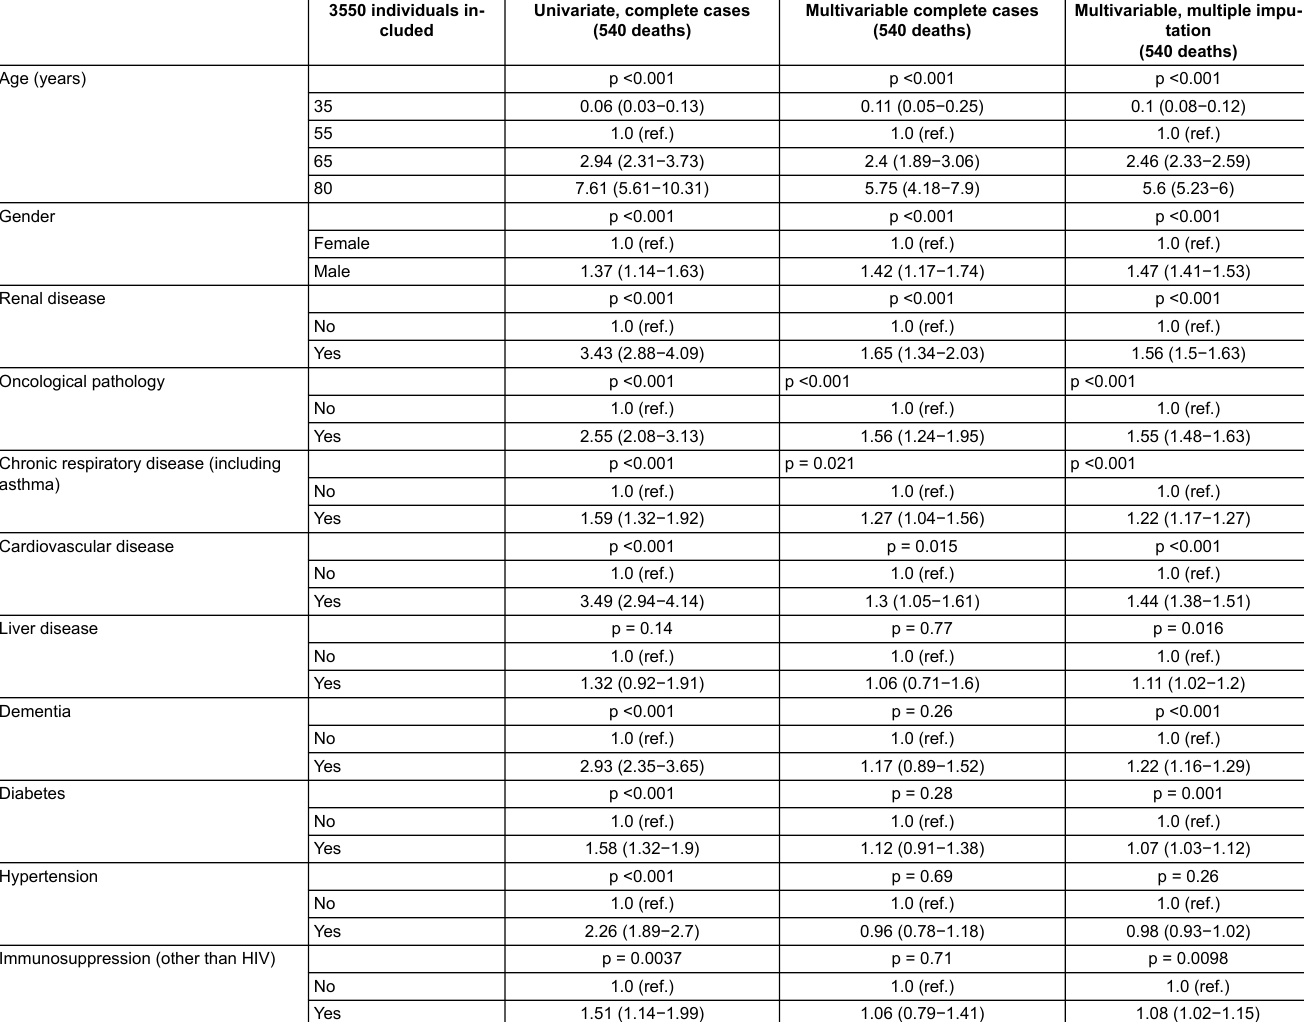
Table 3: Hazard ratios (95% confidence intervals) for in-hospital mortality associated with age and comorbidities in hospitalised COVID-19 patients (n = 3550) in Swiss